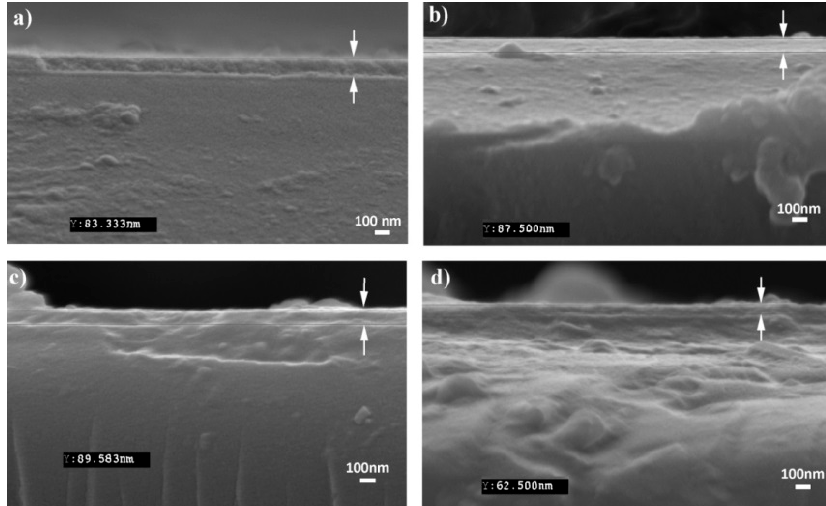
Figure 4. FESEM images of cross-sections of the coated tile surfaces with arrows indicating the TiO 2 coating and Y value showing the measurement of the thickness of the thin film. ( a ) Sample 1BWT with Y = 83.33 nm, ( b ) sample 2WT with Y = 87.500 nm, ( c ) sample 3TST with Y = 89.583 nm, and ( d ) sample 4MWT with Y = 62.500 nm.